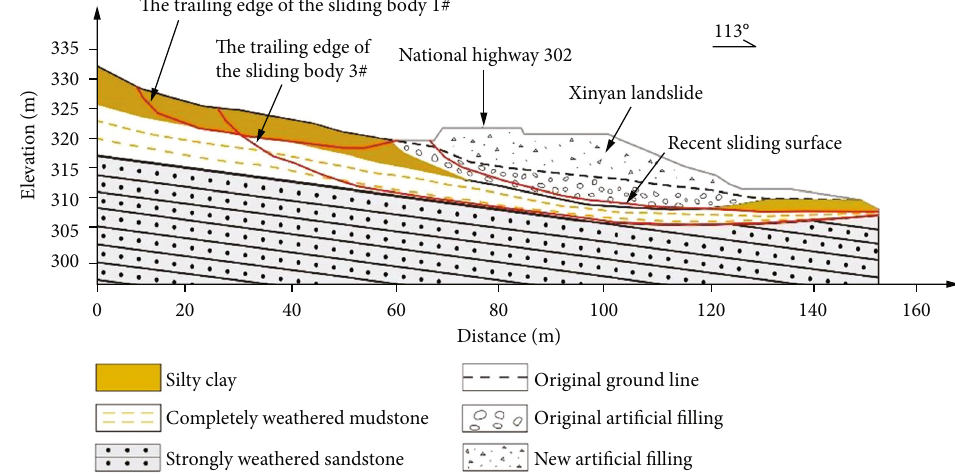
Figure 2: The geological longitudinal pro fi le (pro fi le line D-D ′ in Figure 1) of the Xinyan landslide.